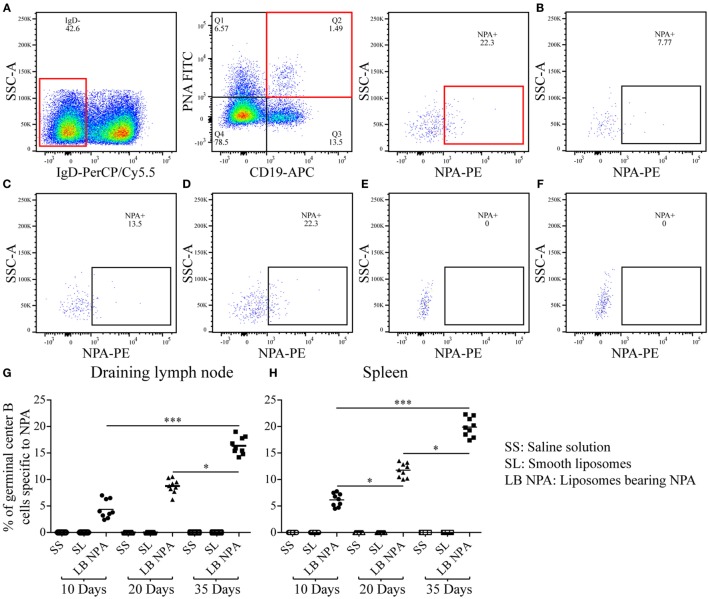
Germinal center B cells specific to NPA from mice inoculated with liposomes bearing NPA. In order to identify NPA-specific germinal center B cells, cell suspensions from the draining lymph nodes and spleens were co-labeled with red-fluorescent PKH26-stained liposomes bearing NPA (NPA-PE), with antibodies to surface IgD and CD19 and with fluorescent PNA and analyzed by flow cytometry. Gating strategy to identify NPA-specific germinal center B cells (IgD−, CD19+, PNA+, NPA+) (A). Region analysis shows the percentage of NPA-specific germinal center B cells on days 10 (B), 20 (C), and 35 (D) in the spleens of mice that had been inoculated with NPA-liposomes. Percentage of NPA-specific germinal center B cells on day 35 in the spleens of mice inoculated with saline solution (E) or with smooth liposomes (F). Percentages of germinal center B cells specific to NPA in the draining lymph nodes (G) and spleen (H). Kruskal–Wallis test with Dunn’s post-test were used for statistical analysis; significance was set at P < 0.05. Asterisks represent statistically significant differences between the indicated groups (*P < 0.05, ***P < 0.001). Each symbol represents pooled cells from two mice. SS, saline solution; SL, smooth liposomes; LB NPA, liposomes bearing NPA.